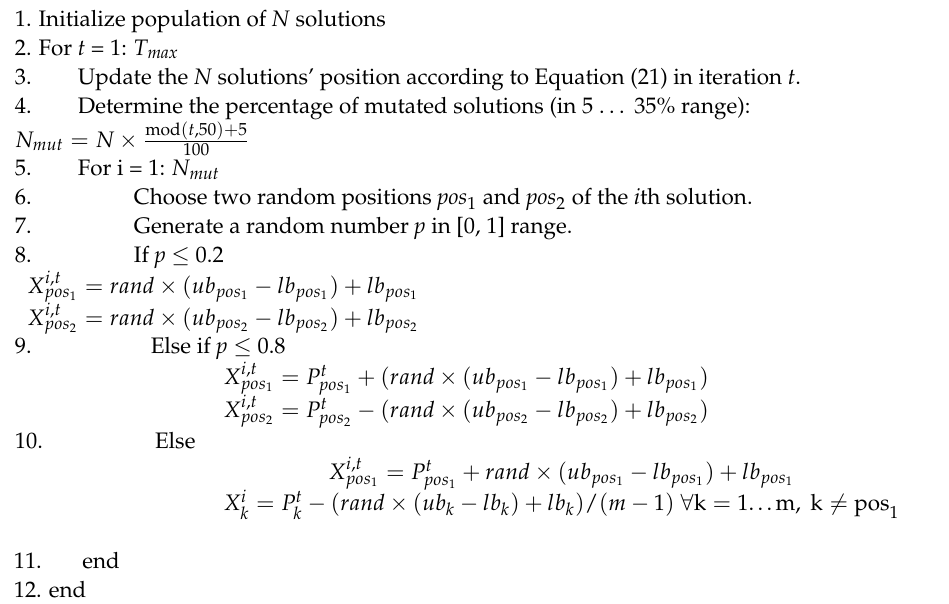
Algorithm 1. Improved Sine-Cosine